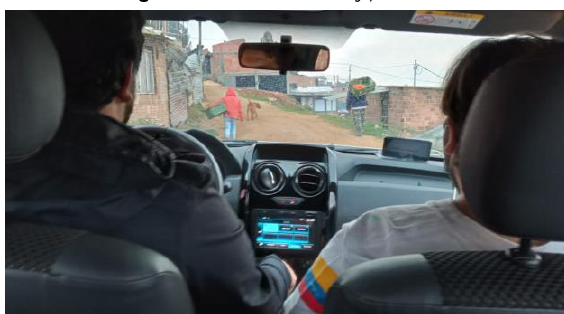
Figure 3 . Streets of Survey, Techo